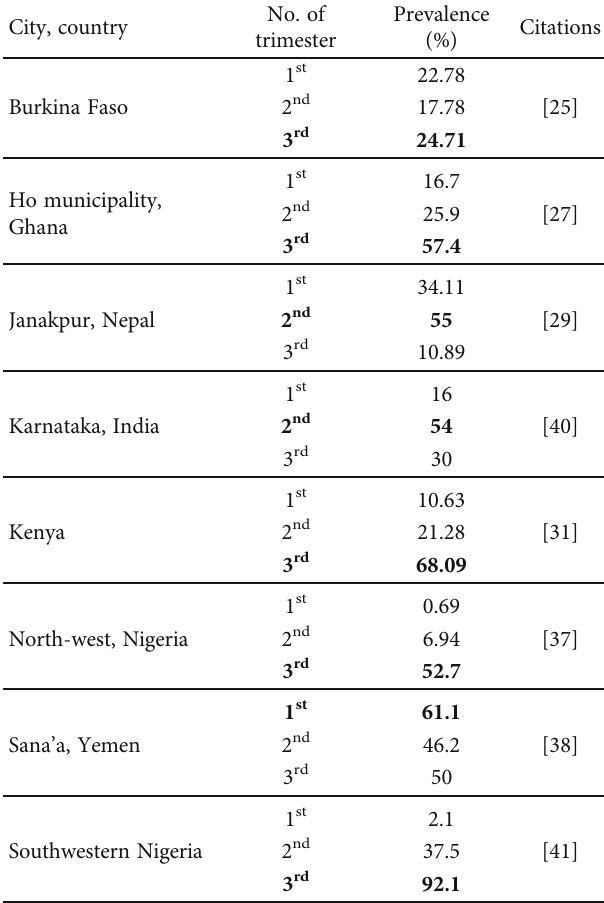
Table 5: Prevalence of VVC during pregnancy according to the no. of trimester; the gestational period with the highest prevalence is in bold form. VVC: vulvovaginal